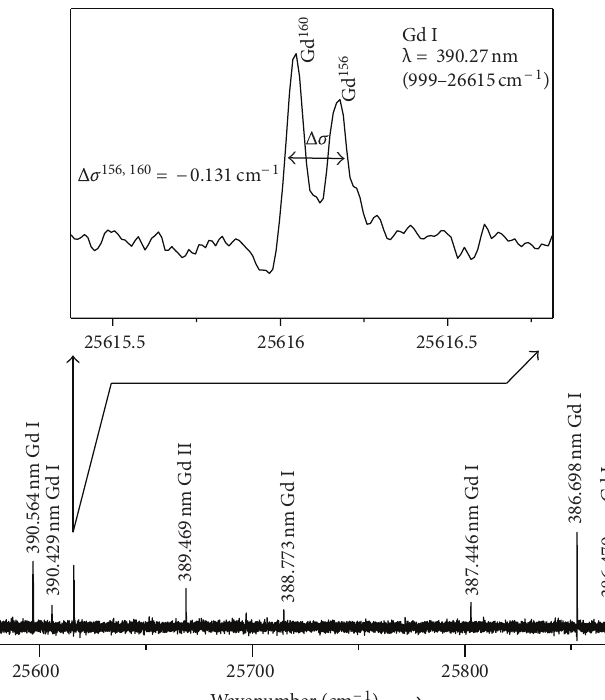
Figure 1: A high resolution spectrum in the region of 25575–25875 cm −1 , recorded on FTS using liquid nitrogen cooled HCL containing highly enriched Gd-156 and Gd-160 isotopes (in 7:10 ratio) in the oxide form. Inset-expanded region showing IS Δ𝜎 156,160 − 0.131cm −1 in the spectral line at 390.270 nm of Gd